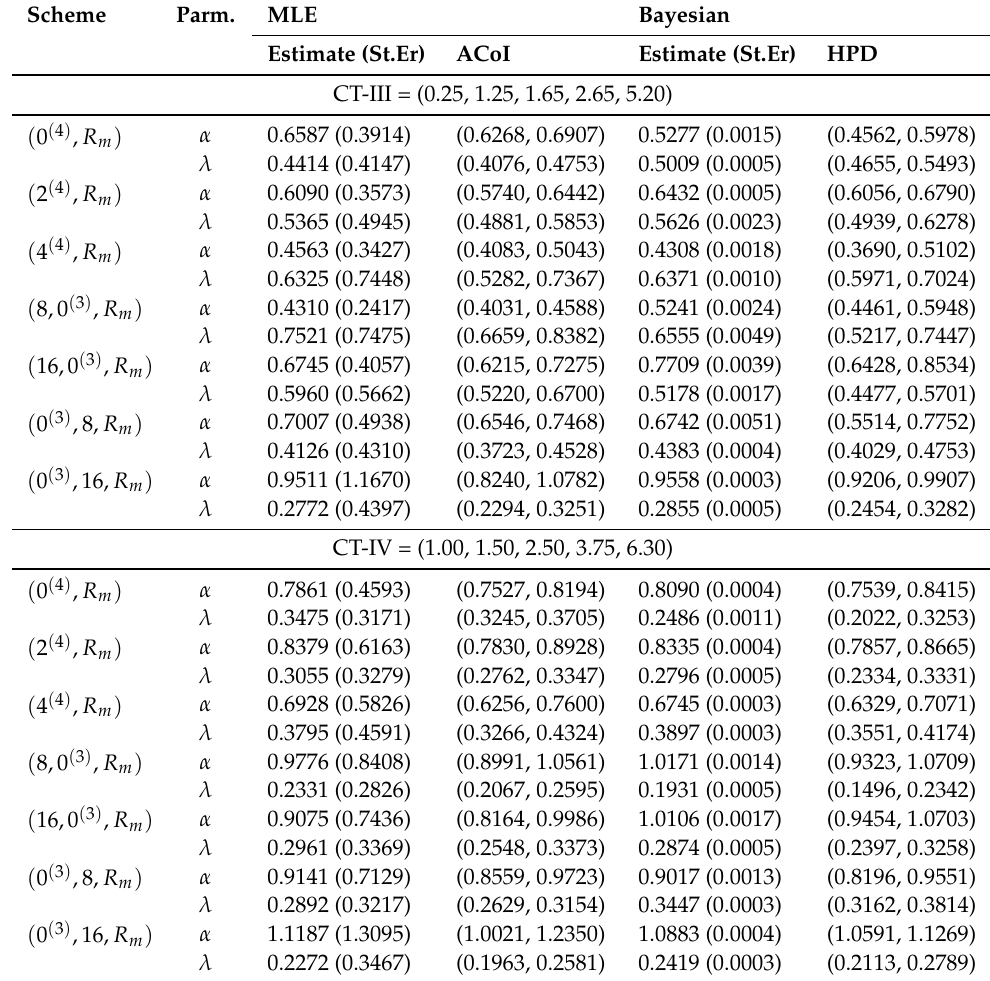
Table 9. ML and BEs with associated St.Er (in practices) and CoIs based on various PT1C schemes for given real data set at m =